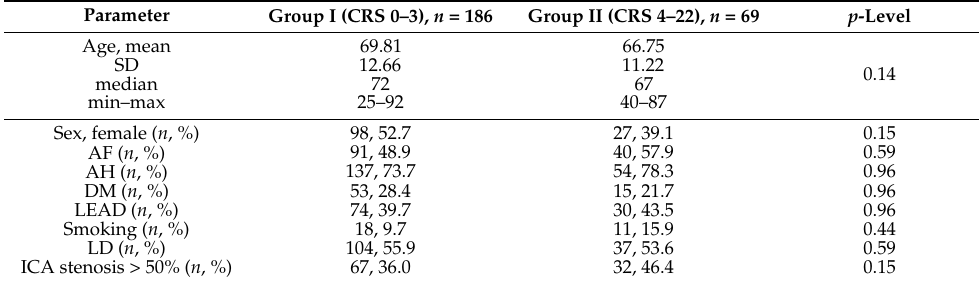
Table 1. Clinical characteristics of